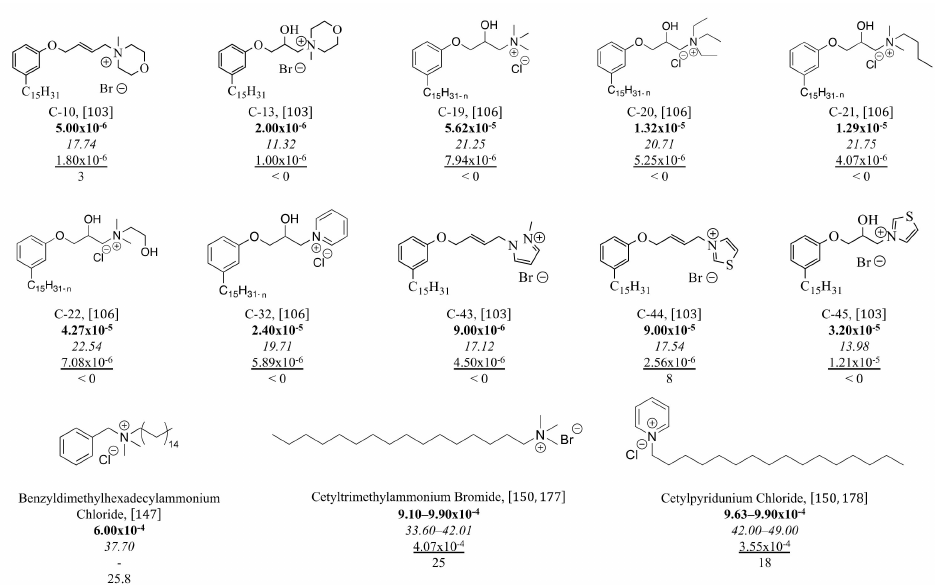
Figure 18. CMC (mol/L, bold), surface tension (mN/m, italics), C 20 (mol/L, underline), and T K ( ◦ C) of cationic CNSL-based surfactants and commercial